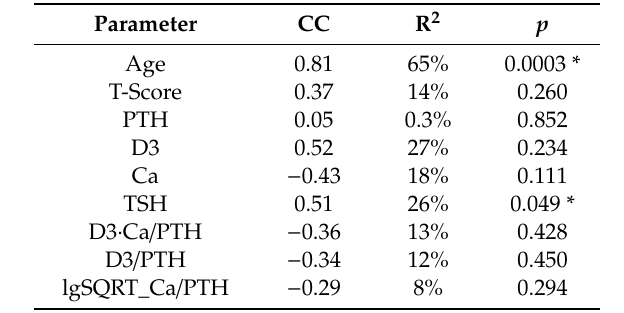
Table 3. The relationship of the 12-month bone regeneration outcome, expressed as BI, to general mineral condition.